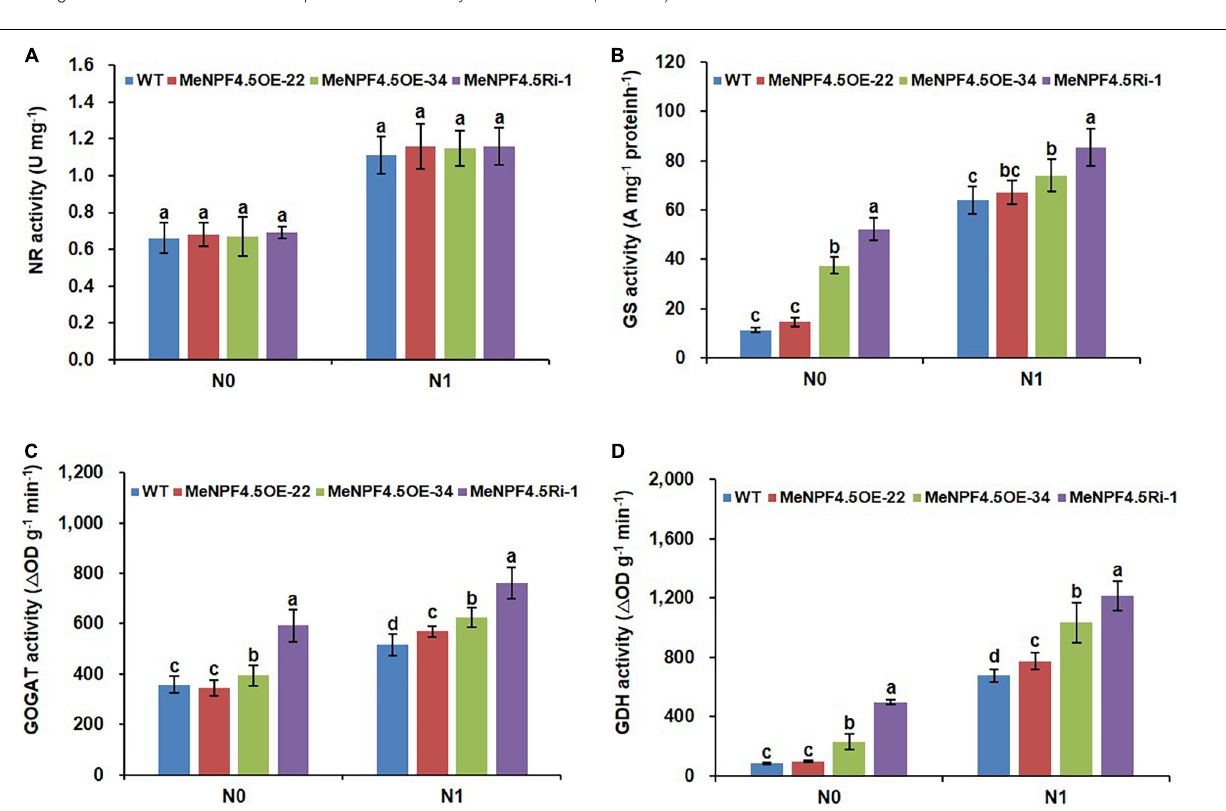
FIGURE 5 | Activity of N metabolism enzymes. Activities of NR (A) , GS (B) , GOGAT (C) , and GDH (D) in the leaves of WT and MeNPF4.5 transgenic cassava harvested from the field. Values are the means of three biological replicates ± SE. Lowercase letters above the bars (a–d) represent significant differences between treatments as determined by Student’s t -test ( P < 0.05). N0, low-N treatment, 0 kg ha − 1 ; N1, normal N treatment, 125 kg ha − 1